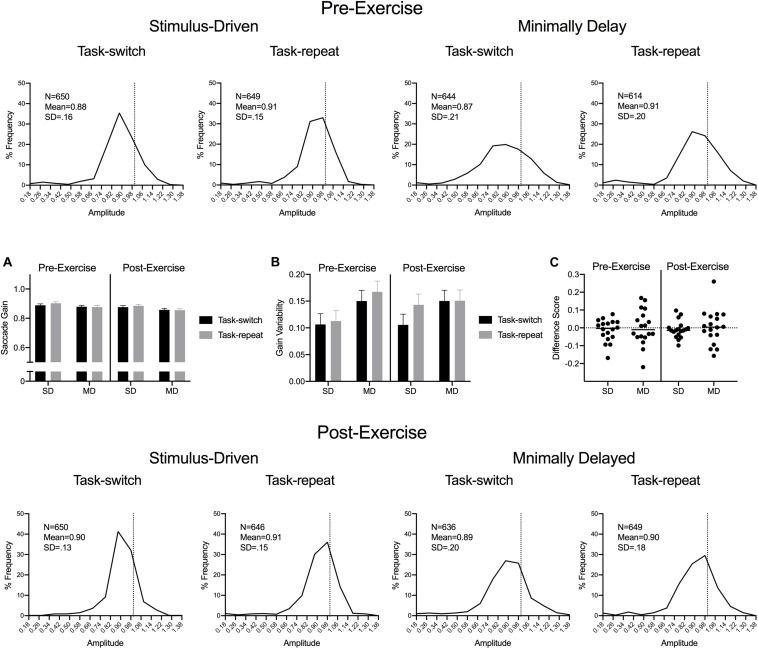
Experiment 1: The main panels show saccade gain (i.e., saccade amplitude/veridical target amplitude) percent frequency histograms (bins width = 0.10) with the vertical dashed line in each panel indicating a unitary gain. Inset panels (A,B) show group mean gain and gain variability for pre- and post-exercise SD and MD task-switch and task-repeat saccades with errors bars representing 95% within-participant confidence intervals. Inset panel (C) presents participant-specific gain difference scores (task-switch minus task-repeat).